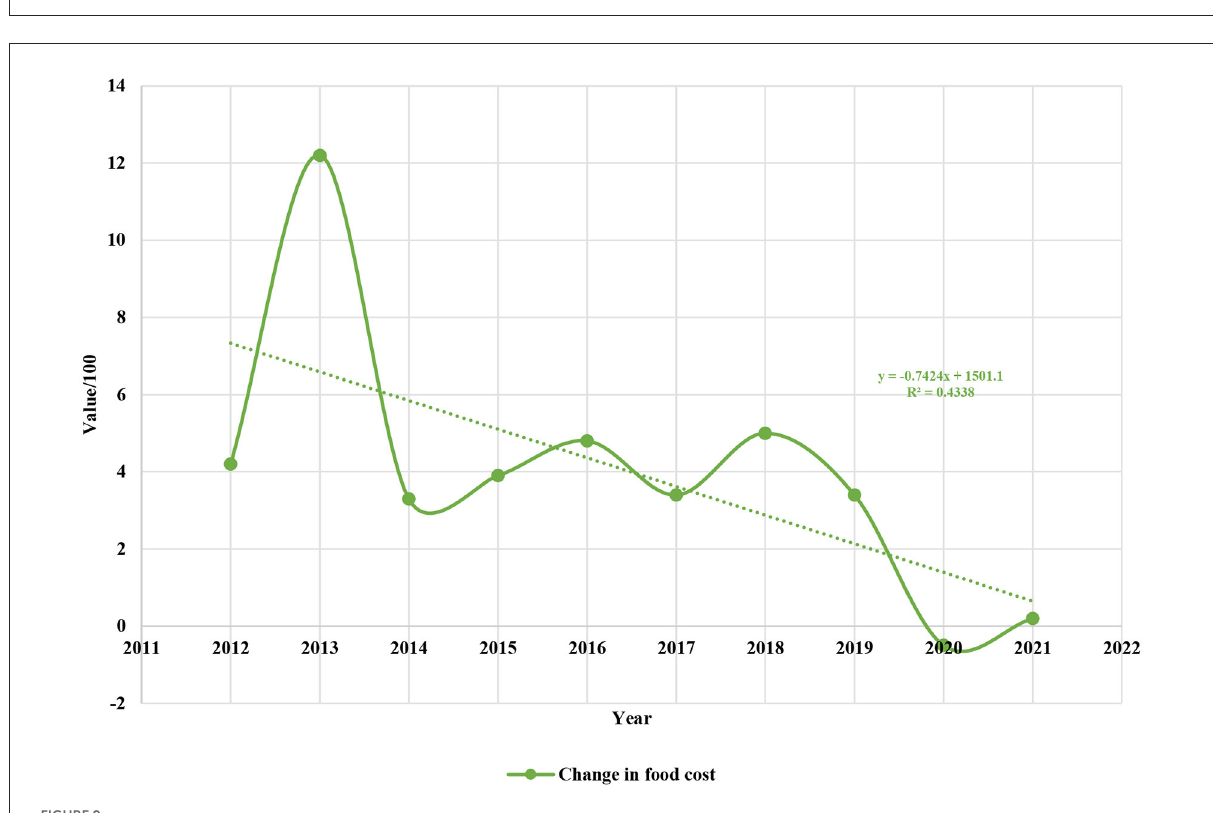
FIGURE9 Change in food costs in Nigeria (2012–2021). Source: